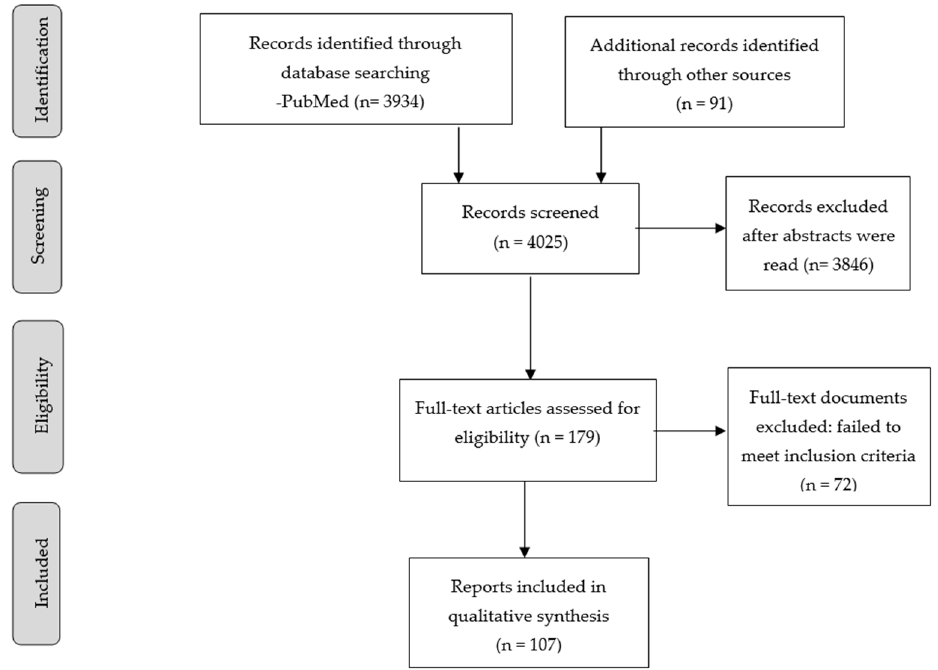
Figure 1. Flow diagram of included studies.